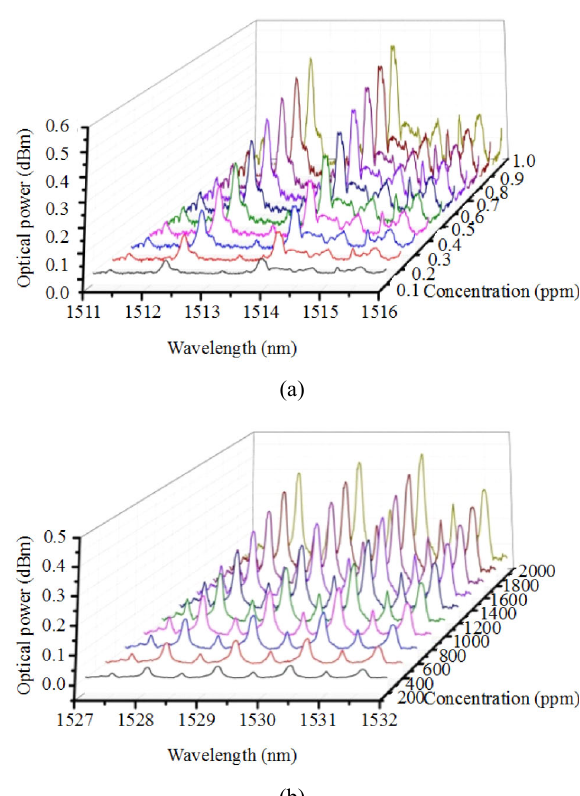
Fig. 9 Data process of the gas concentration test: (a) NH 3 and (b) C 2 H 2 .